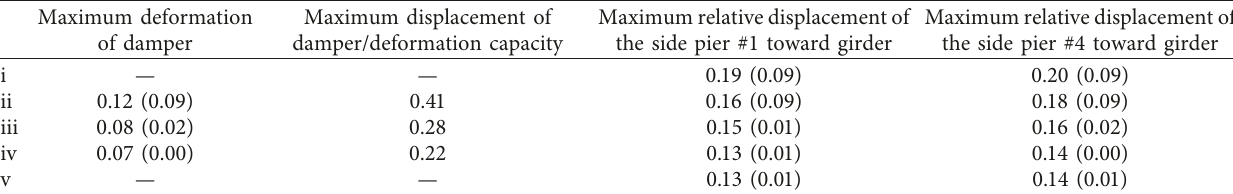
Figure 21: Seismic response for the cases I, iii, and v (the cases ii and iv are missing from this figure to clarify difference among the cases more clearly). (a) Shear force at the bottom of the brake pier. (b) Relative displacement of the side pier toward the girder. Table 7: Displacement of key points in various